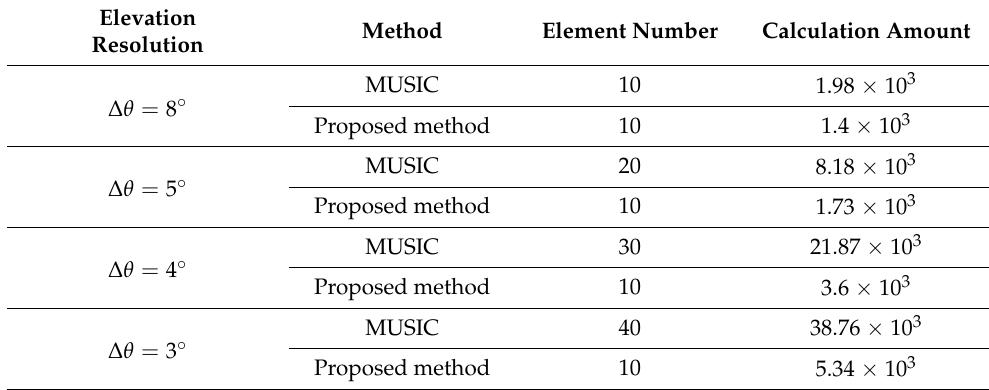
Table 2. The array element number and calculation amount with different elevation